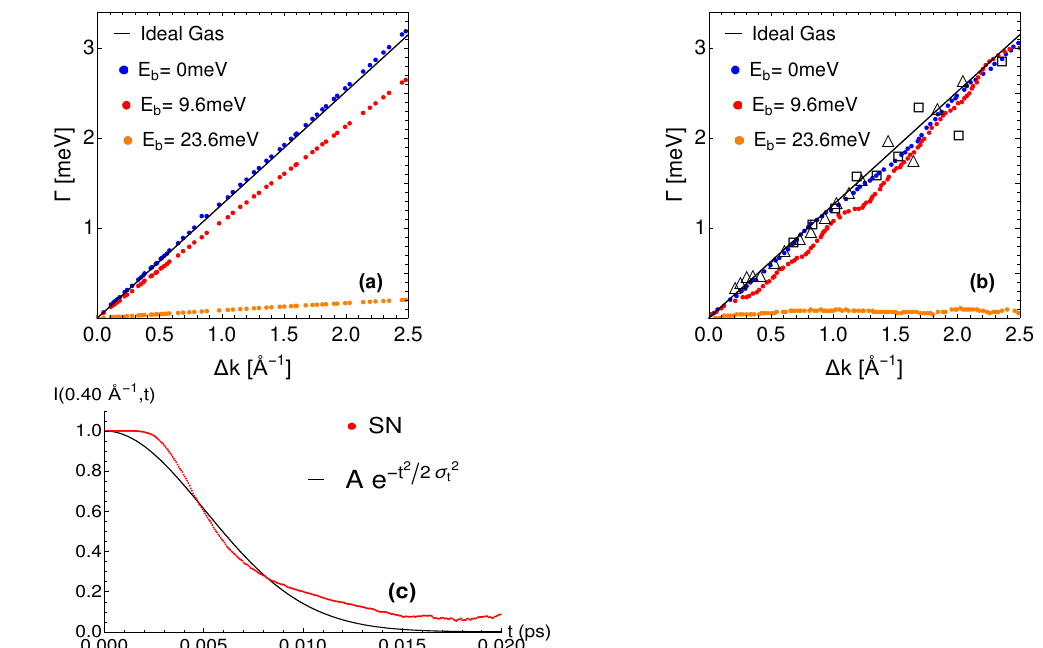
Figure 4. Quasielastic ( Γ ) broadening as a function of ∆ k with a low coverage ( θ = 0.017), small friction coefficient η = 0.03 ps − 1 , surface temperature T = 105 K and the initial adsorbate velocity v 0 = 115 m/s. ( a ) Results of the simulations for potential energy barrier: E b = 0 meV (blue), E b = 9.6 meV (red) and E b = 23.6 meV (orange). ( b ) Results of a Langevin molecular dynamics taken from Ellis et al. [20] with the same values of the energy barrier mentioned before, the theoretical result for a 2D ideal gas (45) and experimental results of the QHAS broadening for two incident beam energies E i (triangles, E i = 10.15 meV; squares, E i = 26.85 meV) for scattering from Xe − 1 adsorbed on a Pt(111). ( c ) The ISF I ( 0.40Å , t ) versus the simulation time t(ps) for an energy barrier E b = 9.6 meV. Our simulation (SN) is represented by a red curve and the Gaussian function e − t 2 /2 σ 2 t by a black